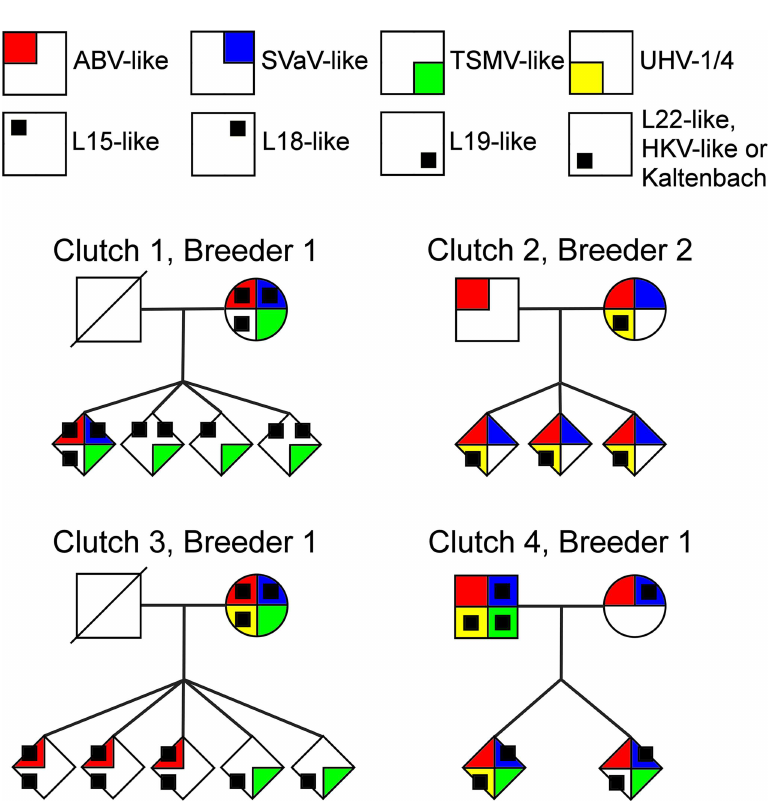
Fig 3. Vertical transmission of viruses presented in the form of a pedigree for the clutches with embryos and perinatal abortions. The viruses sequencedby NGS are indicatedby different colours, no samples were availablefor the fathers of clutches 1 and 3 (indicatedby crossed empty